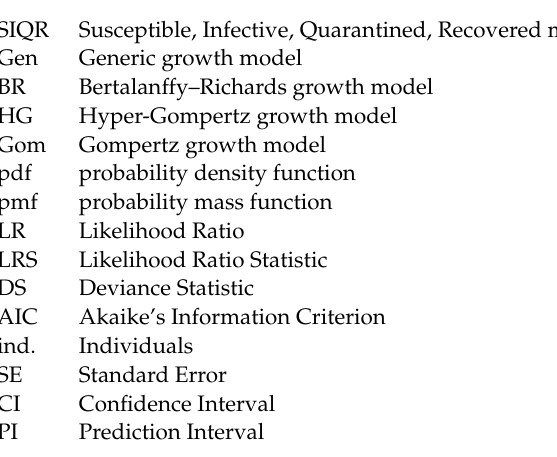
Table A1. Generic growth model [8] and its limiting cases: population size ( ϕ t ), growth rate ( ˙ ϕ t ), and growth acceleration ( ¨ ϕ t ).